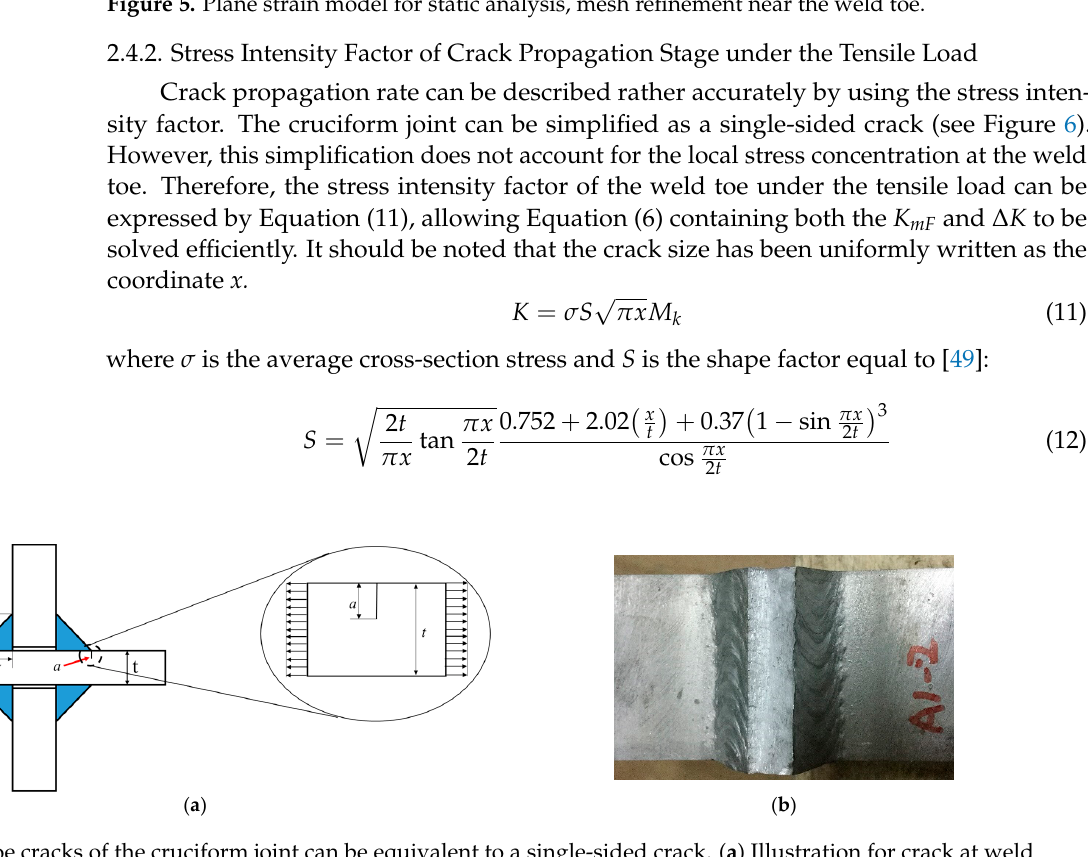
Figure 6. Weld toe cracks of the cruciform joint can be equivalent to a single-sided crack. ( a ) Illustration for crack at weld toe, ( b ) Fatigue fracture at weld toe.